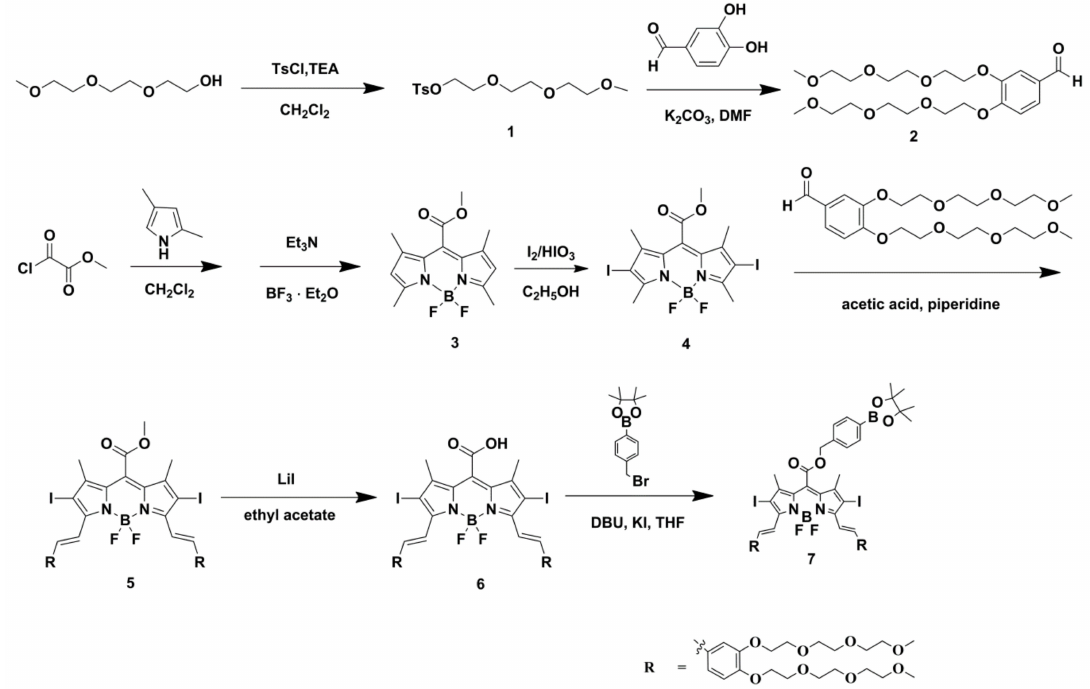
Figure 1. Synthesis of the H 2 O 2 -responsive photosensitizer.